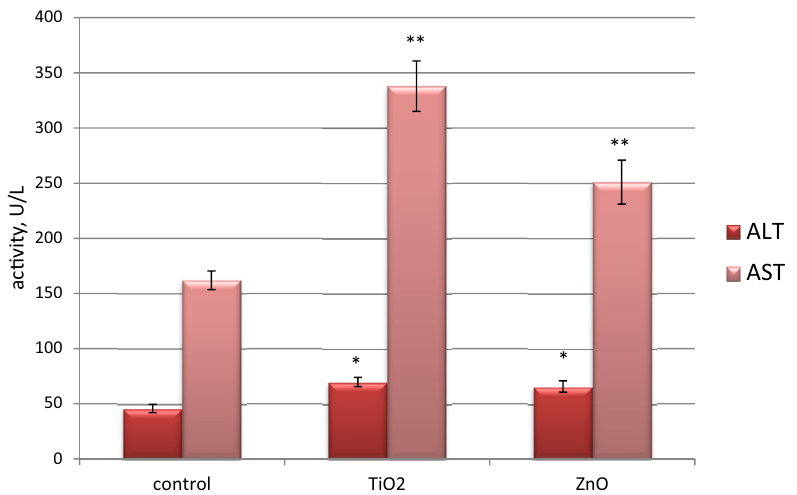
Figure 10. Activity of alanine aminotransferase (ALT) and aspartate aminotransferase (AST) in the blood plasma of rats in the control group (n = 7) and under the chronic in vivo effect of ZnO and TiO 2 ANs for 6 months (n = 7); * p < 0.05 and ** p < 0.001 compared with